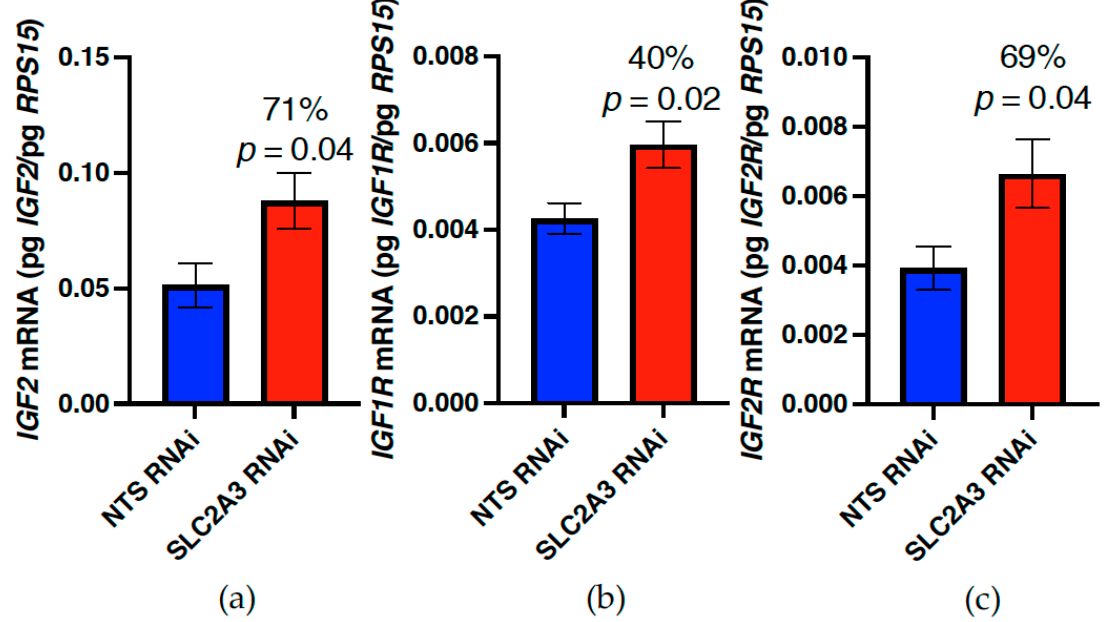
Figure 7. Impact of SLC2A3 RNAi on placental concentrations of ( a ) IGF2, ( b ) IGF1R, and ( c ) IGF2R mRNA. Data are shown as means ± SEM. NTS, non-targeting sequence; RNAi, RNA interference.